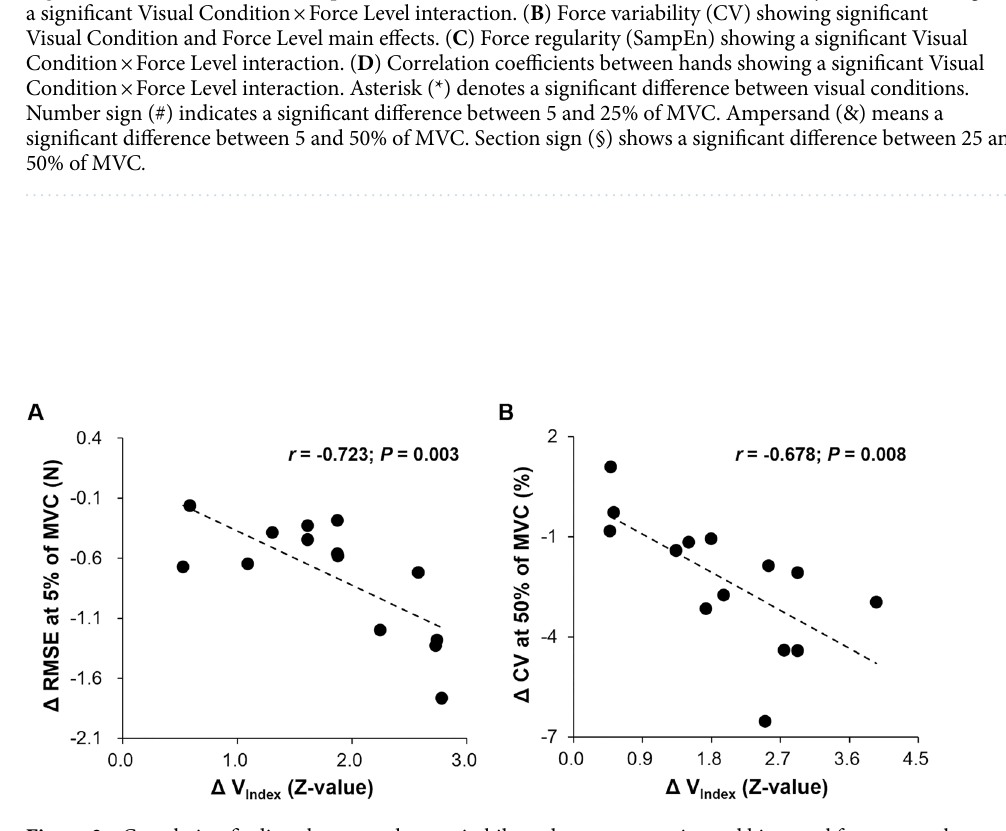
Figure 3. Correlation findings between changes in bilateral motor synergies and bimanual force control performances from vision to no-vision conditions. ( A ) Negative correlation between bilateral motor synergy (V Index ) and force accuracy (RMSE) at 5% of MVC. ( B ) Negative correlation between bilateral motor synergy (V Index ) and force variability (CV) at 50% of